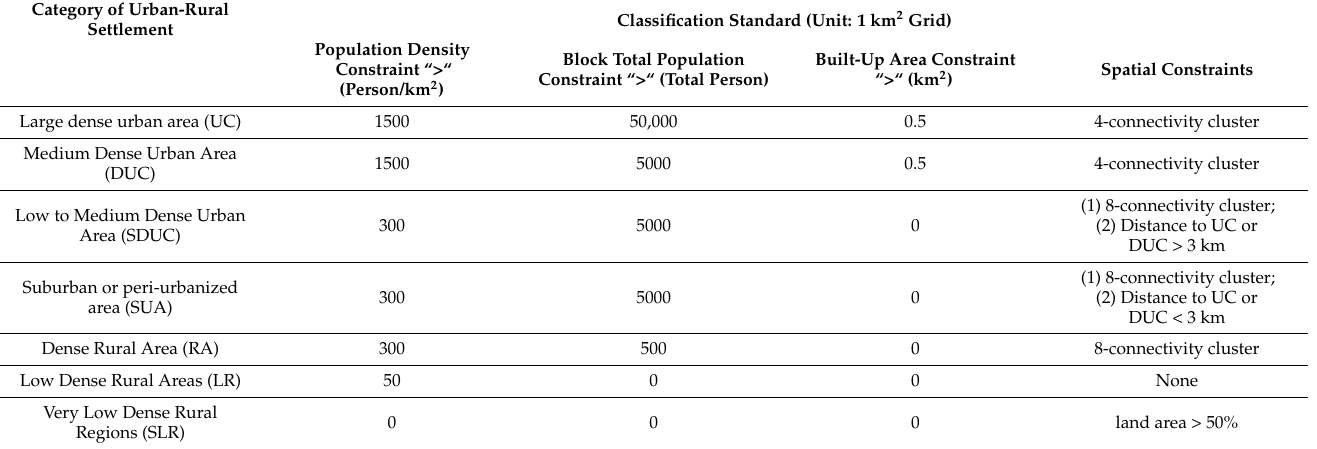
Table 1. Classification of urban-rural